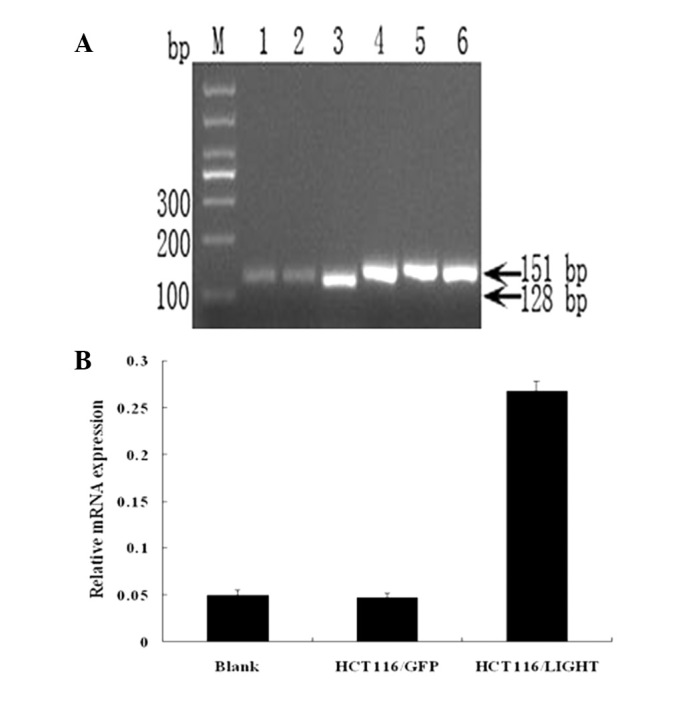
Effects of overexpressing LIGHT on the mRNA level of LIGHT. (A) Electrophoresis and semiquantitative analysis of PCR products. The mRNA level of LIGHT was higher in the HCT116/LIGHT cells compared with the HCT116/GFP and HCT116 cells. Lanes 1 and 4, HCT116; lanes 2 and 5, HCT116/GFP; lanes 3 and 6, HCT116/LIGHT; M, DL1000 DNA marker. (B) Statistical analysis of the mRNA level of LIGHT relative to that of GAPDH. LIGHT, lymphotoxin-related inducible ligand that competes for glycoprotein D binding to herpesvirus entry mediator on T cells.